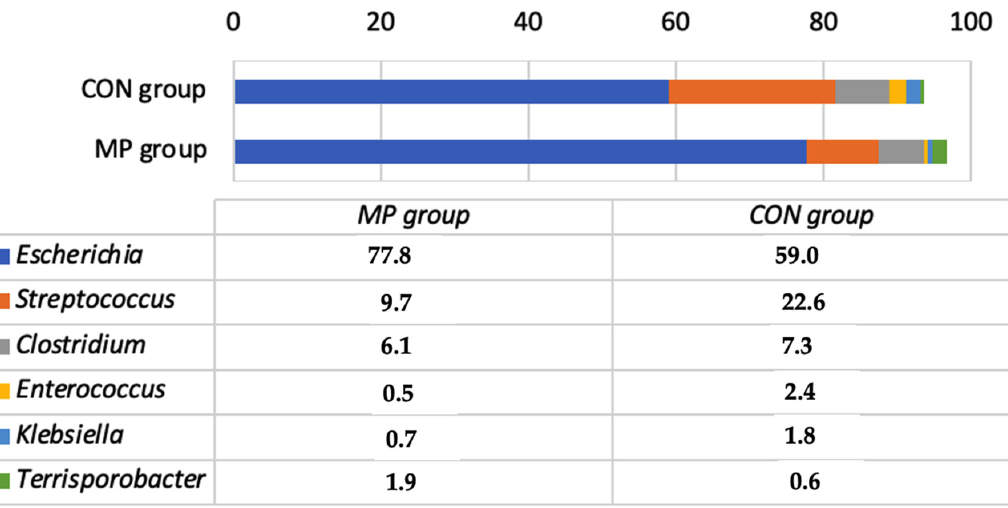
Figure 1. Bacterial genera percentage prevalence in the faeces of calves before the experiment. The genera are included in the list only if the prevalence was at least 1% of the total bacterial reads in the faeces of both groups combined. CON, calves fed with milk replacer only; MP, calves fed with milk replacer and supplemented with fermented milk permeate. At the end of the experiment, 28,265 and 26,968 bacterial reads were obtained from the faeces of the MP and CON groups, respectively. The microbial profiles differed significantly between the groups (Figure 2).